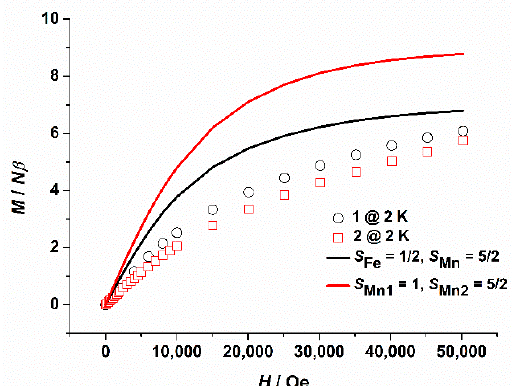
Figure 4. The field dependence of magnetization curve for complexes 1 and 2 at 2 K. The solid lines represent the Brillouin function that corresponds to two S Fe = 1/2 and one S Mn = 5/2 spin states with g = 2.0 (black) and two S Mn1 = 1 and one S Mn2 = 5/2 spin states with g = 2.0 (red).